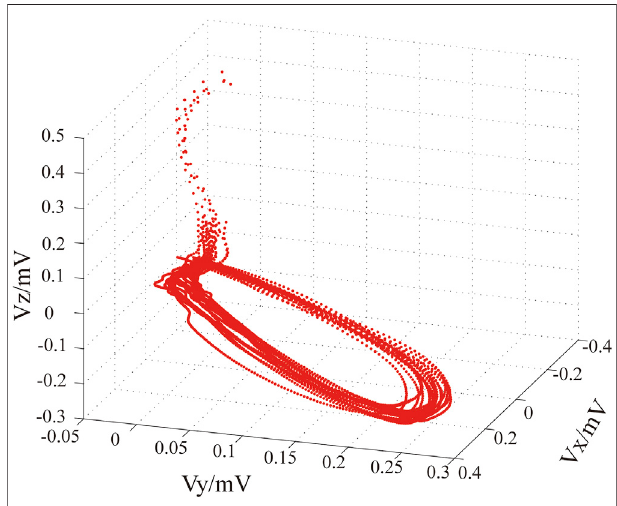
FIGURE 3 | Three-dimensional VCGs ’ ST-T segments derived from 20sec, 12-lead